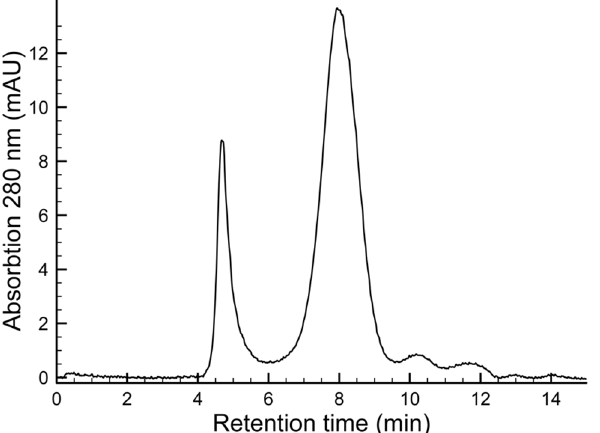
Fig 5. Size exclusion chromatogram of purified CO-029. Size exclusion of the purified CO-029 protein after proteolytic cleavage and removal of the GFP-tag. The elution was monitored with the absorbance at 280